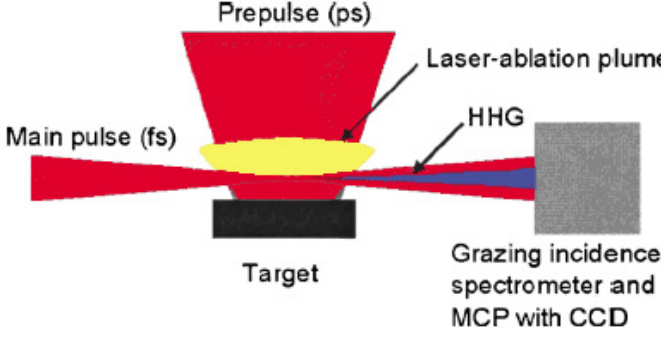
Figure 4. Experimental setup. The prepulse was focused on the target surface and, after 88 ns, the femtosecond laser pulse was focused onto the laser-ablation plume. The generated harmonics (HHG: high-order harmonic generation) were measured by using the grazing incidence spectrometer with the MCP (micro-channel plate) and CCD (charge coupled device) camera.